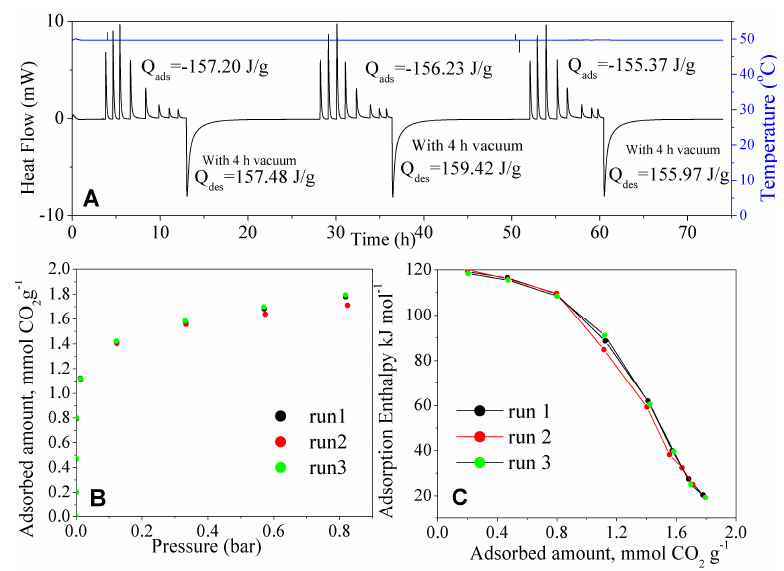
Figure 11. ( A ) Thermogram (at 50 °C) for CO 2 adsorption on the three rounds, ( B ) corresponding CO 2 adsorption isotherms, and (C) differential enthalpies of CO 2 adsorption (at 50 °C) for the three rounds of adsorption on the same MSG20I30 sample.